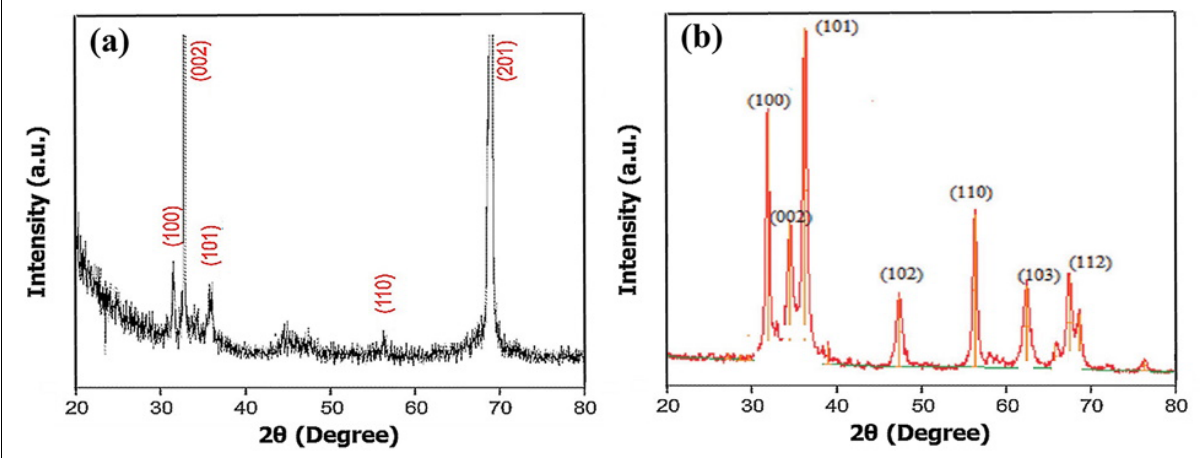
Figure 5: X-ray diffractometer pattern of the ZnONPs – (a) ZnO_CNPs and (b) ZnO_MPs – showing the presence of pure ZnO crystalline